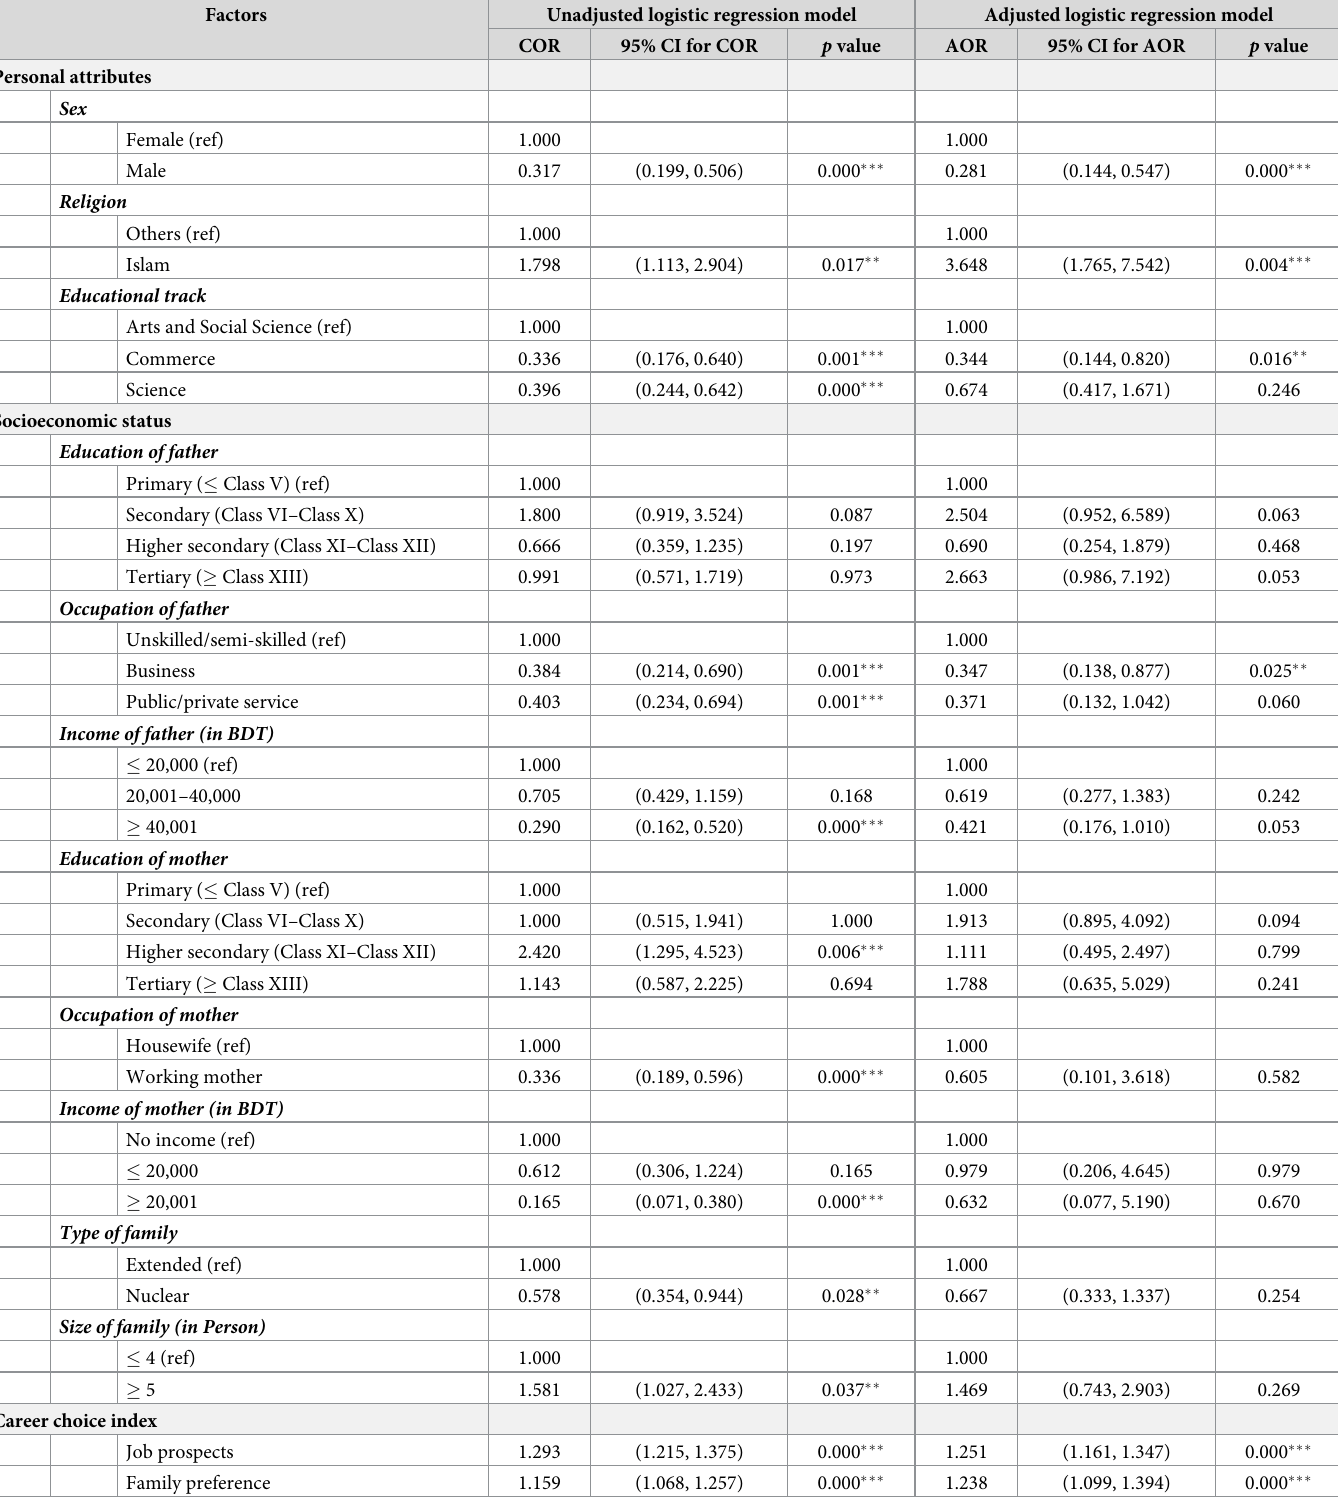
Table 3. Unadjusted and adjusted ORs for factors associated with career